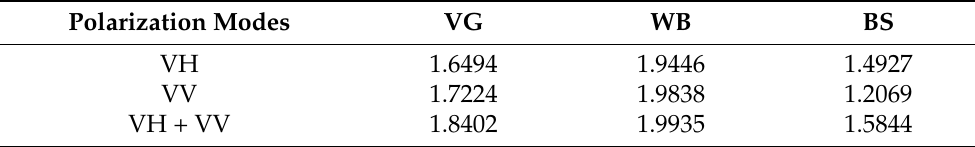
Table 5. JM distances between impervious surfaces and other ground objects under different polar- ization